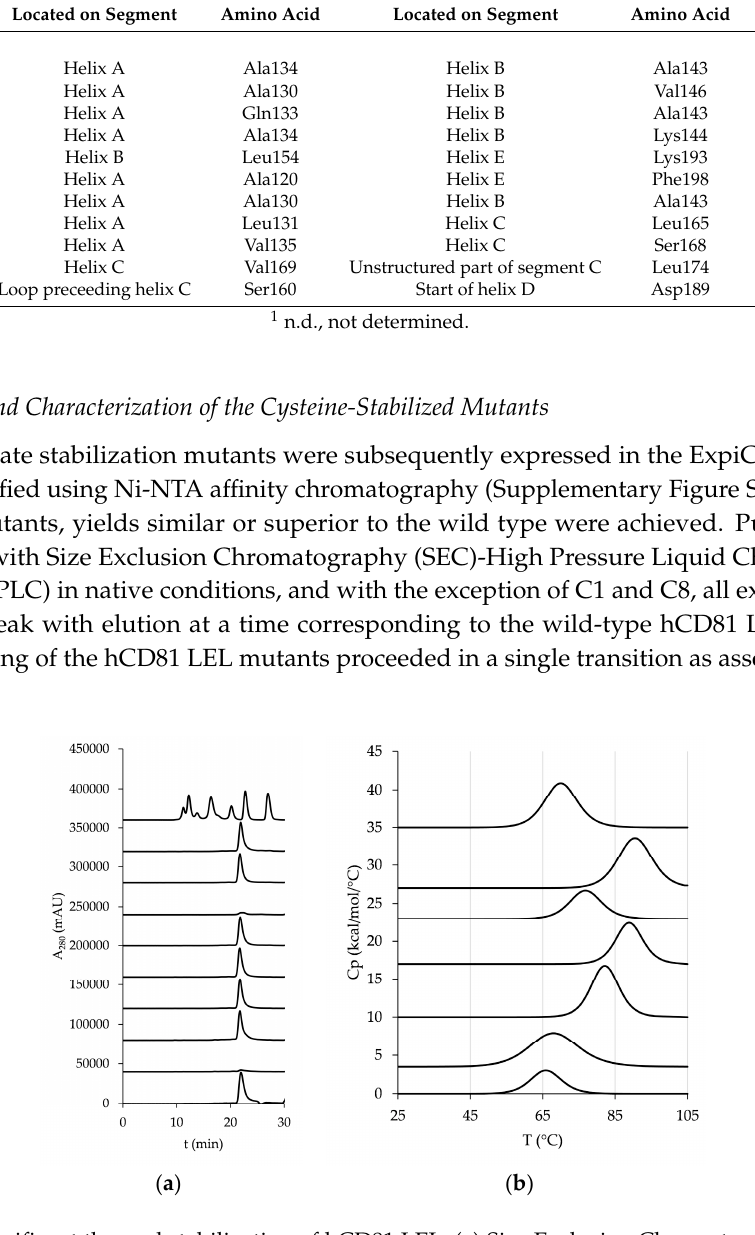
Figure 3. Significant thermal stabilization of hCD81 LEL. ( a ) Size Exclusion Chromatography-High Press ure Liquid Chromatography (SEC-HPLC) profiles: from bottom to top: wild-type hCD81 LEL, C1, C2, C3, C4, C7, C8, C9, C11 and molecular weight standards at 670, 158, 44, 17, and 1.3 kDa (Bio-Rad); ( b ) DSC profiles of (from bottom to top): wild-type hCD81 LEL, C2, C3, C4, C7, C9, and C11.